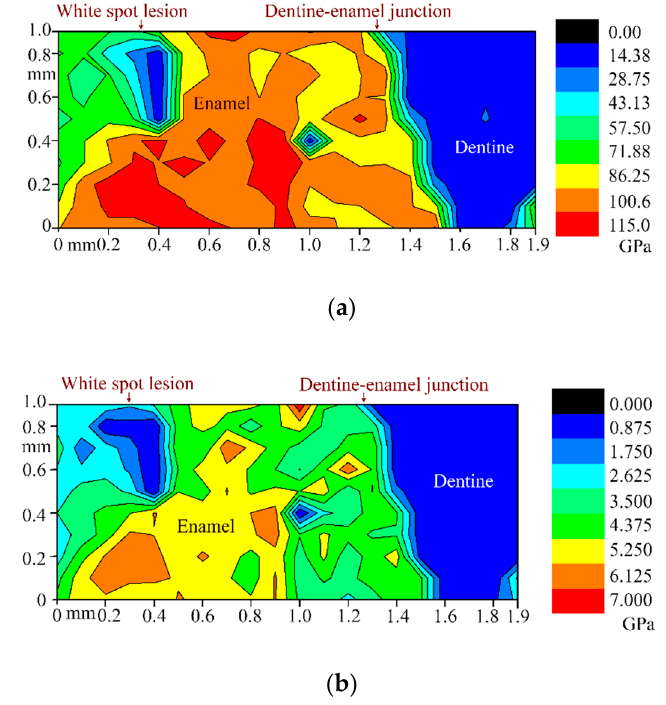
Figure 4. Maps of the mechanical characteristics of WSL and surrounding tooth areas: ( a ) reduced Young’s modulus; ( b ) indentation hardness. Table 2. Mechanical properties of the tooth areas.